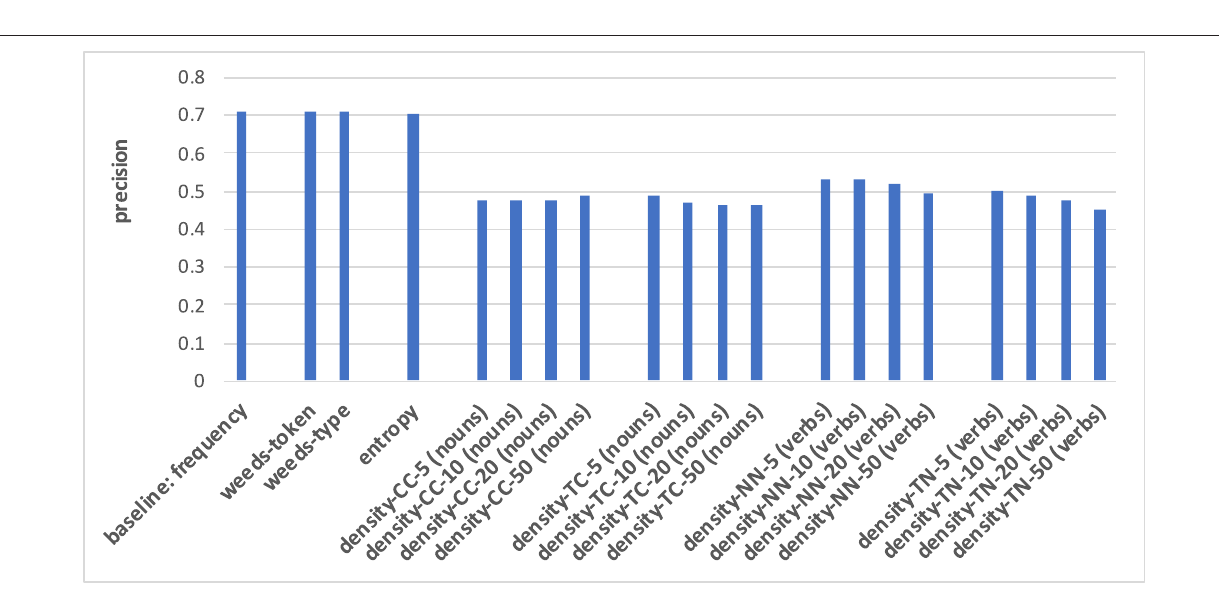
FIGURE 8 | Pair-wise precision results for hypernymy of verbs relying on an N-V-A vector space. Densities take only nouns as context/neighbour words into